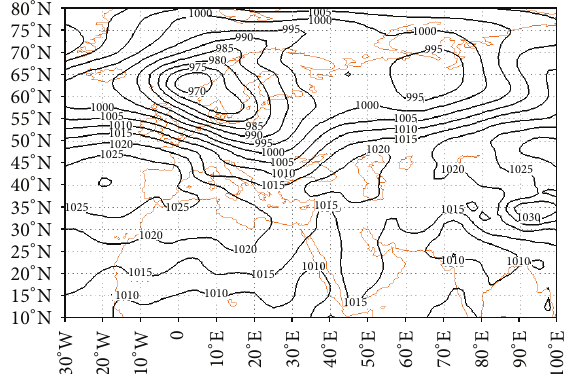
Figure 9: Sea level pressure map.